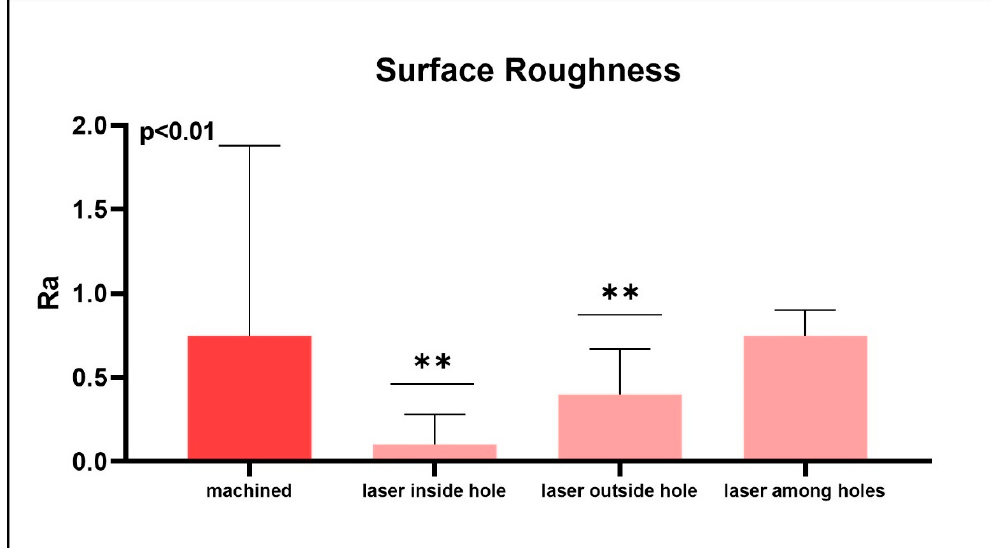
Figure 5. Surface roughness of the machined implants and laser treatment inside the holes generated outside the holes and among the holes (** p < 0.01).